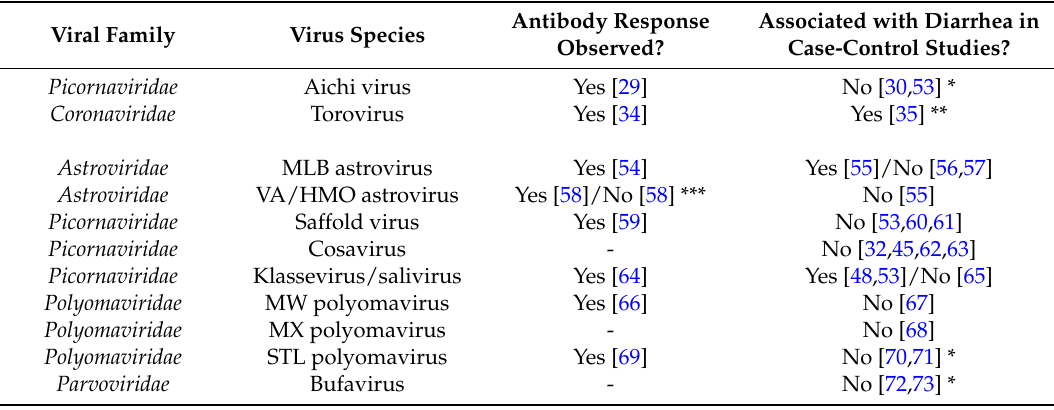
Overview of the pathogenesis studies performed for new viruses identified in the gastrointestinal tract ˆ. Virus